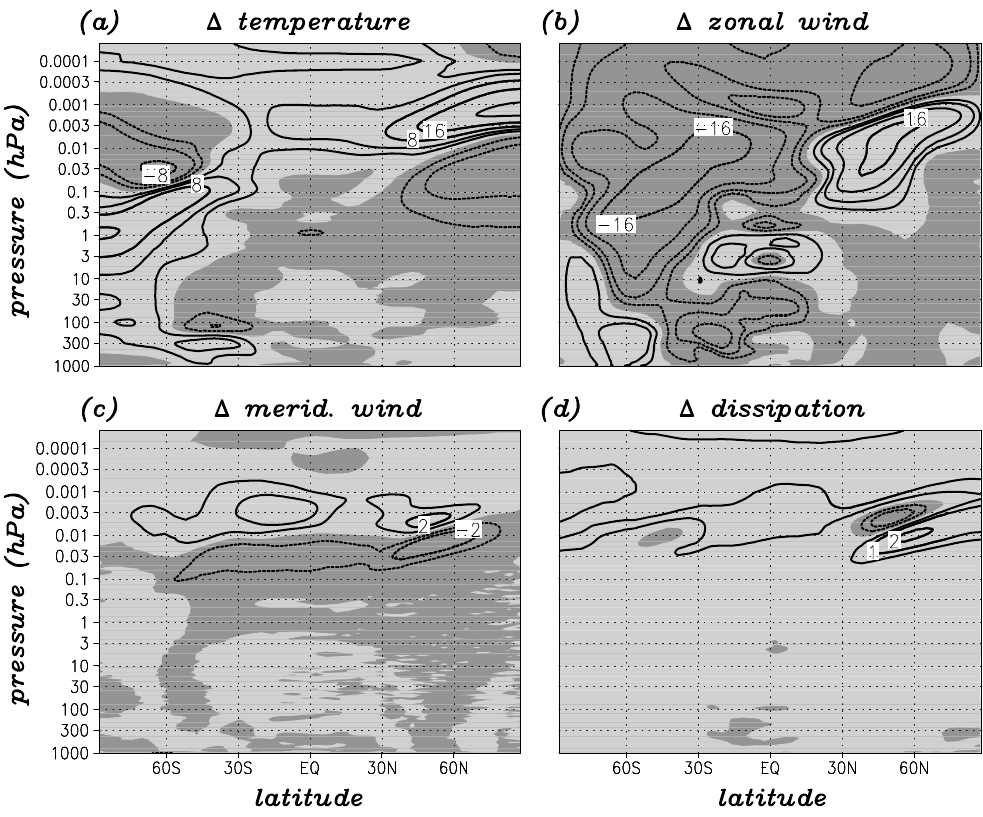
Fig. 5. Simulated zonal-mean differences in the “July 2002” simulation from the “normal July” run. (a) Temperature (contours ± 2 , 4 , 8 , 16 , 32K). (b) Zonal wind (contours ± 2 , 4 , 8 , 16ms − 1 ). (c) Eulerian meridional wind (contours ± 1 , 2ms − 1 ). (d) Dissipation Figure 5: Simulated zonal-mean differences in the ’July 2002’ simulation from the ’nor- (contours ± 0 . 5 , 1 , 2Kd − 1 ). Zero contours are not drawn. Positive and negative values are indicated by light and dark shading. mal July’ run. (a) Temperature (contours 2 , 4 , 8 , 16 , 32 K). (b) Zonal wind (contours ± 2) negligible sponge-layer feedback (Shepherd et al., 1996) 2 , 4 , 8 , 16 ms − 1 ). (c) Eulerian meridional wind (contours 1 , 2 ms − 1 ). (d) Dissipation in our ± ± (contours 0 . 5 , 1 , 2 Kd − 1 ). Zero contours are not drawn. Positive and negative values are ± indicated by light and dark shading.